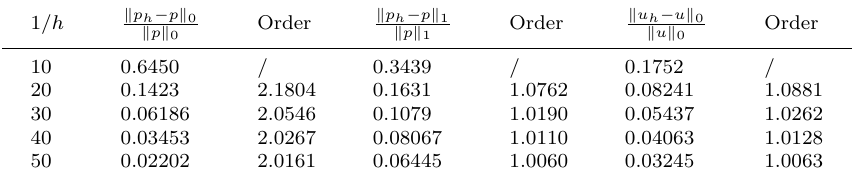
Table 3. The superconvergence results with P 2 1 /h